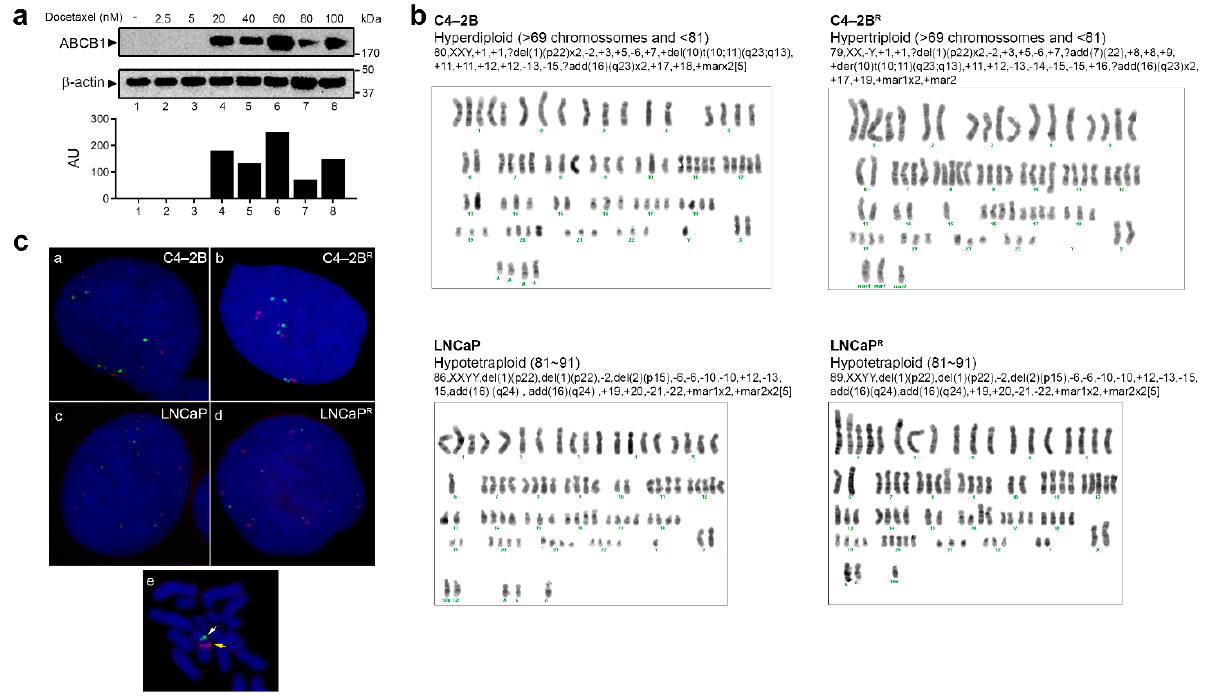
Figure 5. Karyotypic and gene level evaluation of ABCB1 copy number in drug-resistant cell lines. ( a ) Western blot analysis of ABCB1 expression in consecutive passages of LNCaP and C4-2B cells generated during the process of acquisition of drug resistance. Full Western blot image can be found in Figure S1. Lower panel: graphs depicting densitometry measurements of ABCB1 levels relative to those of β -actin in arbitrary units (AU). ( b ) Representative G-band karyotypic analyses of the parental and docetaxel-resistant cell lines. ( c ) Fluorescence in situ hybridization (FISH) using probes specific for chromosome 7 centromere (Green) and ABCB1 gene (Red) was performed in C4-2B (subpanel a), C4-2B R (subpanel b), LNCaP (subpanel c), and LNCaP R (subpanel d) parental and resistant cell lines, respectively. Subpanel e shows a representative image of metaphase FISH of an LNCaP cell, confirming that the probes used recognized discrete regions in the same chromosome.